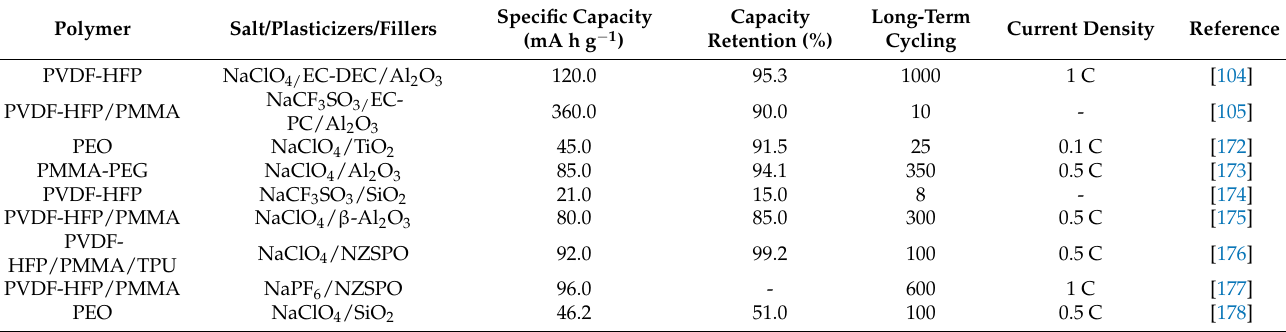
Table 8. Lists of GPEs and their electrochemical performance in